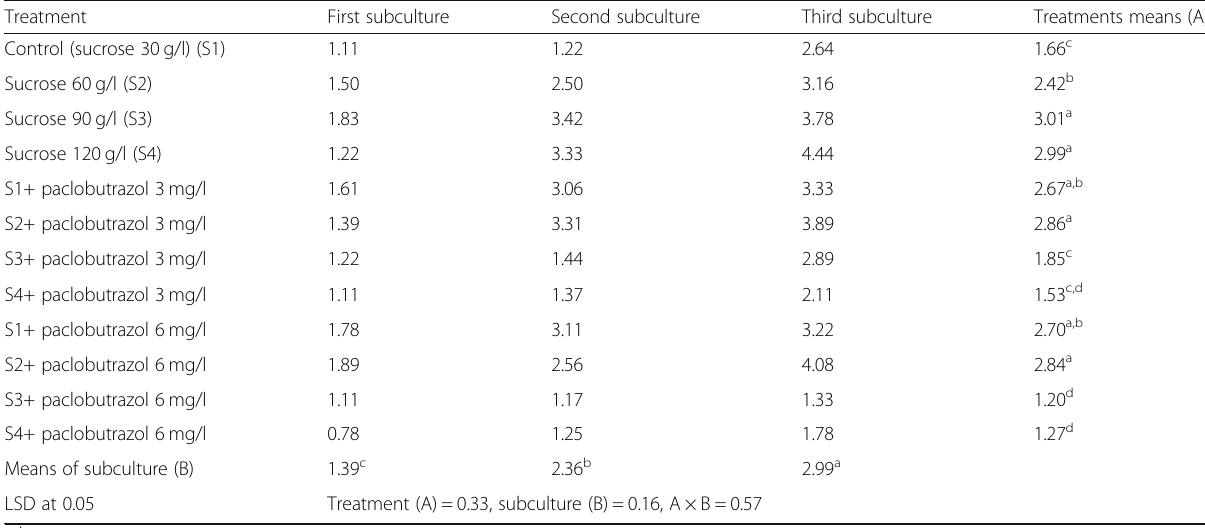
Table 3 Bulblet formation of Lilium under effect of sucrose and paclobutrazol at various concentrations during three repeated subcultures Treatment